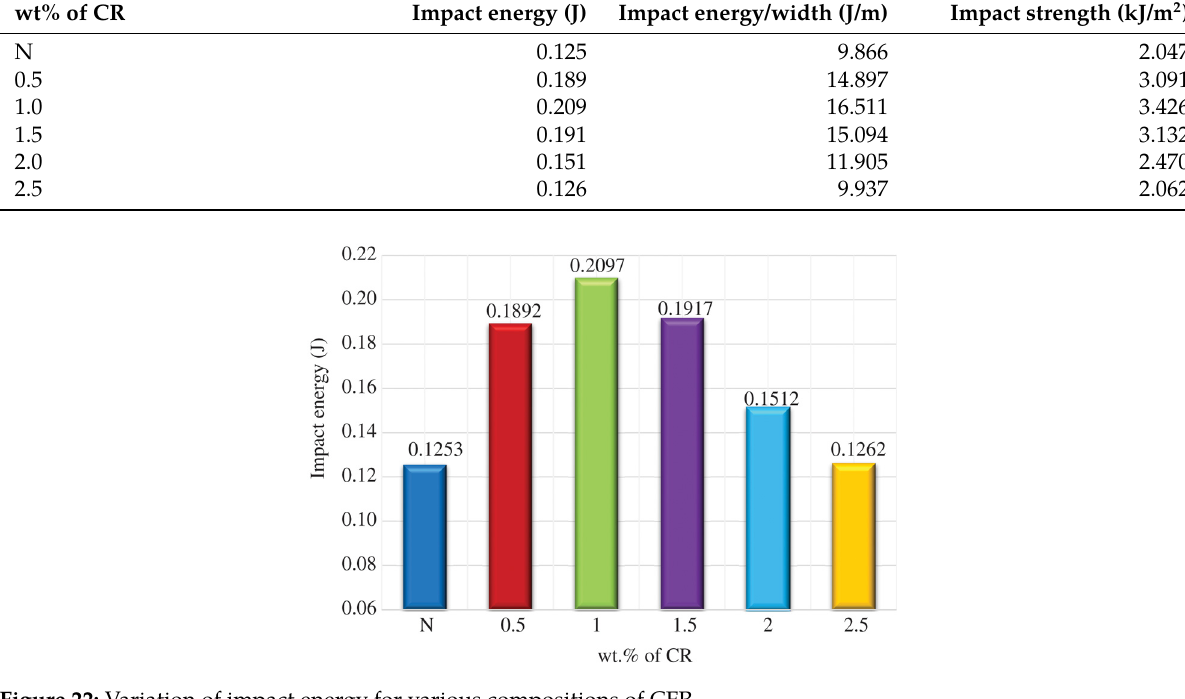
Figure 22: Variation of impact energy for various compositions of